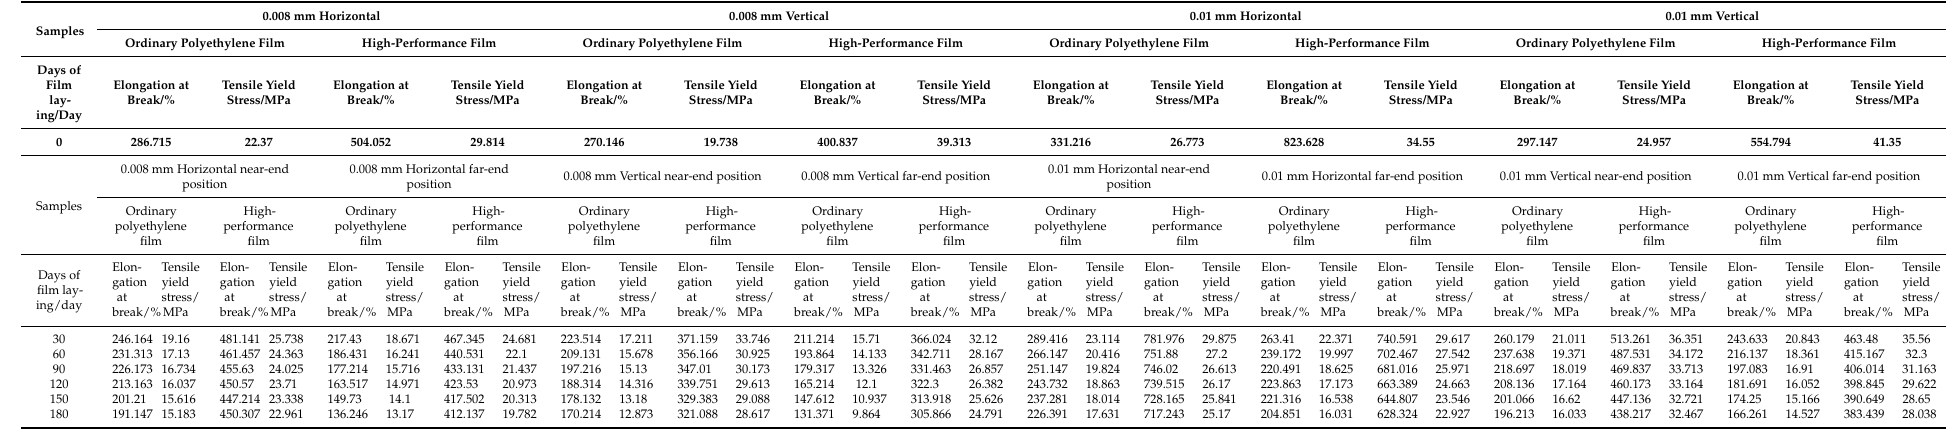
Table 2. Results of film tensile test during service period of 0–180